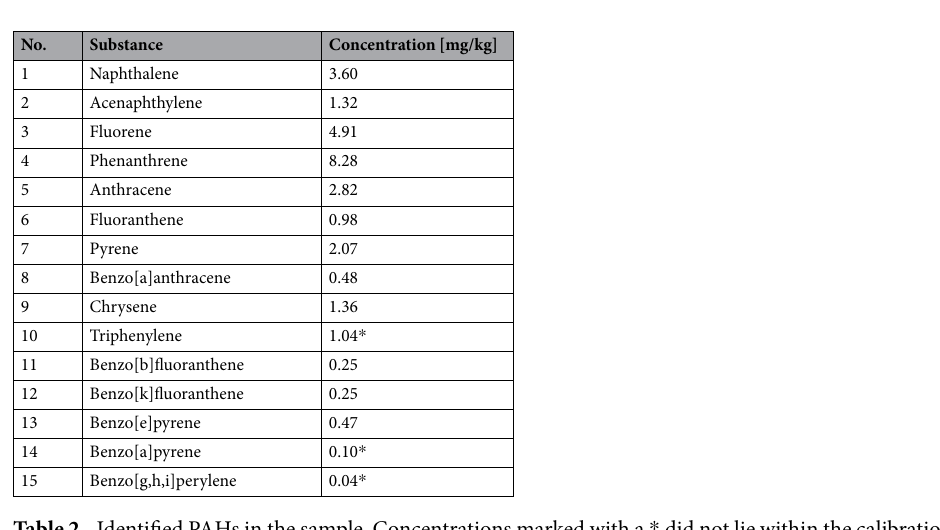
Figure 2. GC-MS-chromatogram of the diluted sample extract corresponding to FD 9. The largest peaks identified as naphthalene derivatives are indicated with arrows.